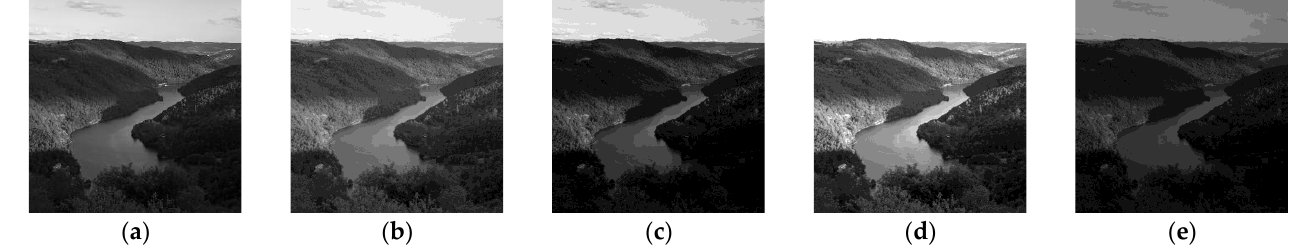
Figure 1. Brightening/darkening an image thanks to LIP laws. ( a ) Original image f ; ( b ) Image 0.75 ⨻ f ; ( c ) Image 1.25 ⨻ f ; ( d ) Image f ⨺ 100; ( e ) Image f ⨹ 100.